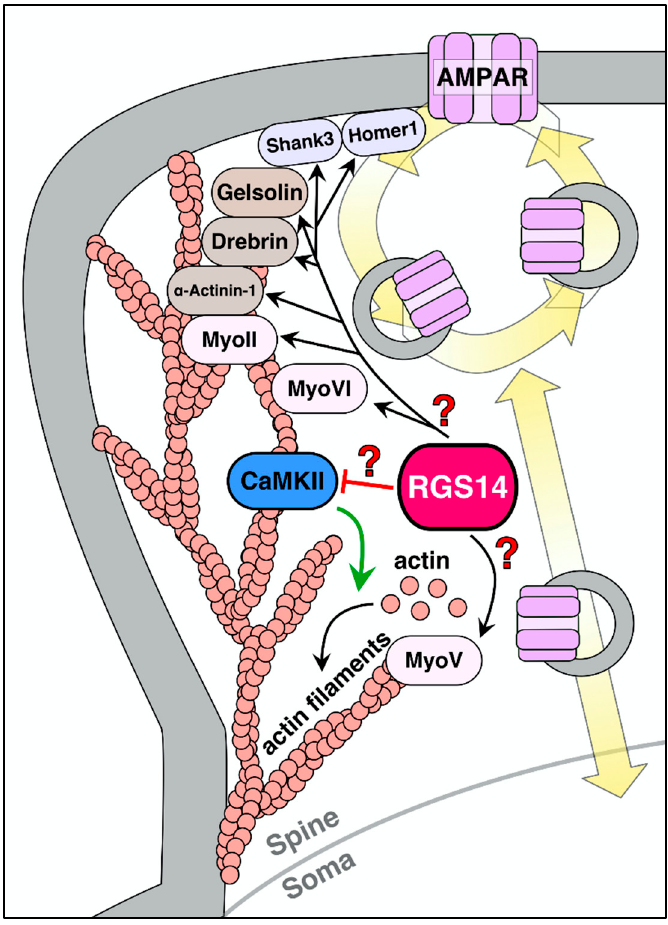
Figure 4. RGS14 potential regulation of dendritic spine morphogenesis . RGS14 exists in the brain as a high molecular weight complex with proteins associated with cytoskeletal architecture and dendritic spine morphogenesis, including actin-binding proteins ( α -actinin-1, drebrin, gelsolin), myosins (MyoII, MyoV, MyoVI), and CaMKII. Myosins also mediate AMPAR trafficking between the plasma membrane and the soma. Additionally, human/primate RGS14 could possibly interact with postsynaptic density proteins (e.g., Homer1, Shank3) that link actin cytoskeleton to glutamate receptors and scaffold receptors to key signaling molecules.